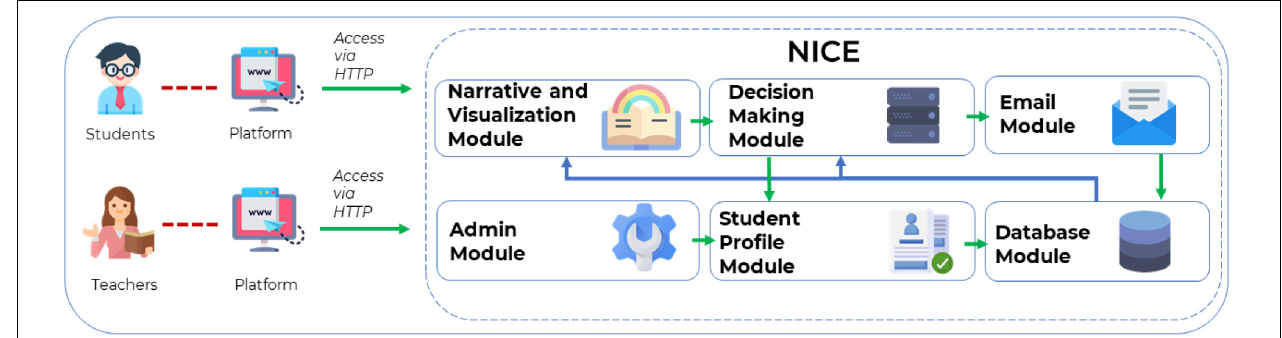
FIGURE 1 | Narrative Integrated Career Exploration (NICE) platform